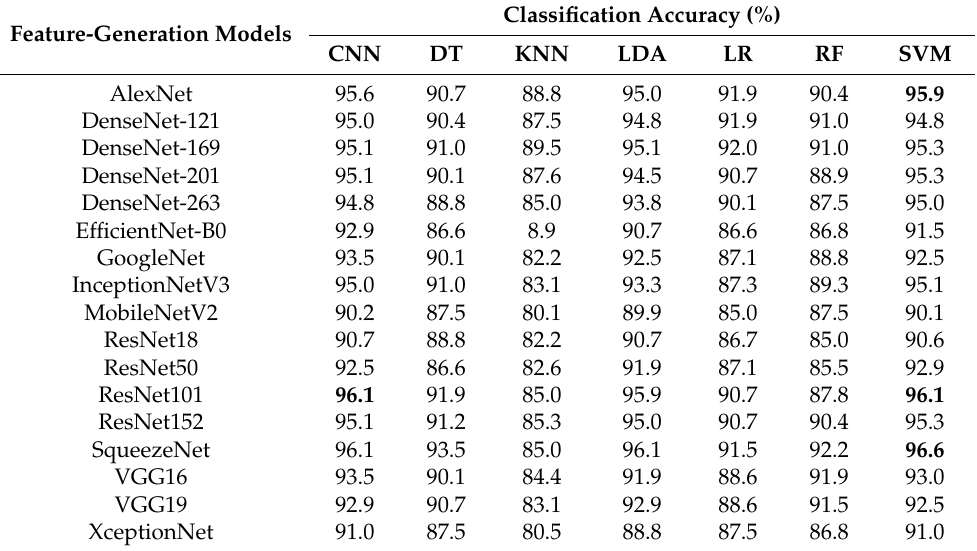
Table 1. Comparison analysis of pre-trained transferred models as feature-extractor and machine- learning-classification algorithms.